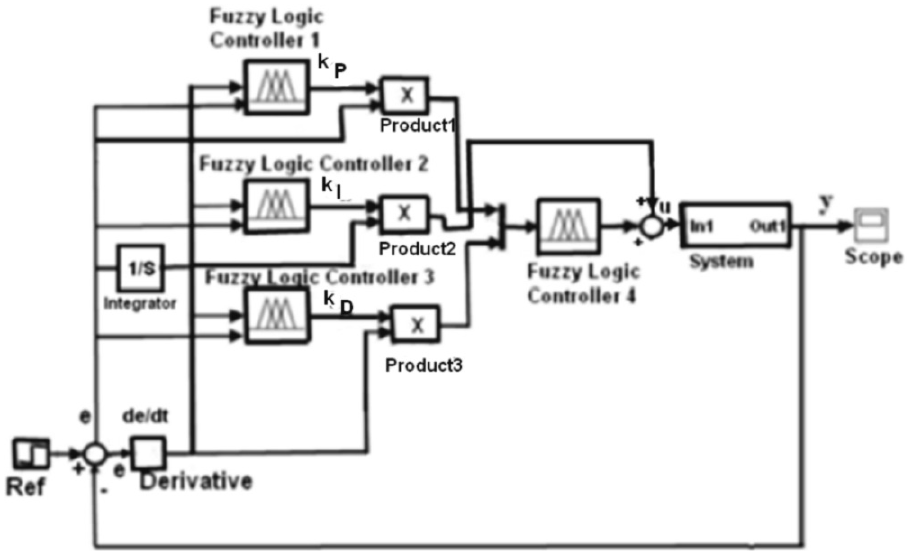
Figure 5. Matlab model block